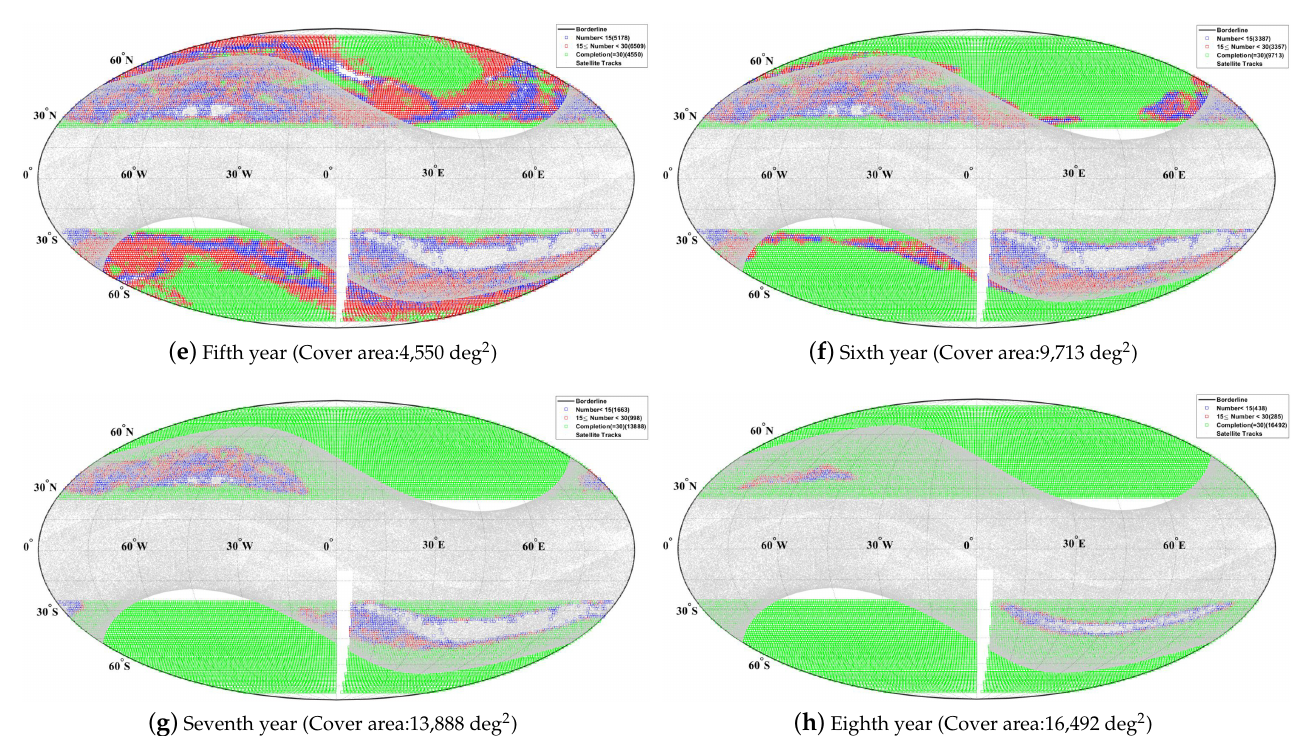
Figure 10. Presentation of observation results from the first year to the eighth year with parameter γ 1 =